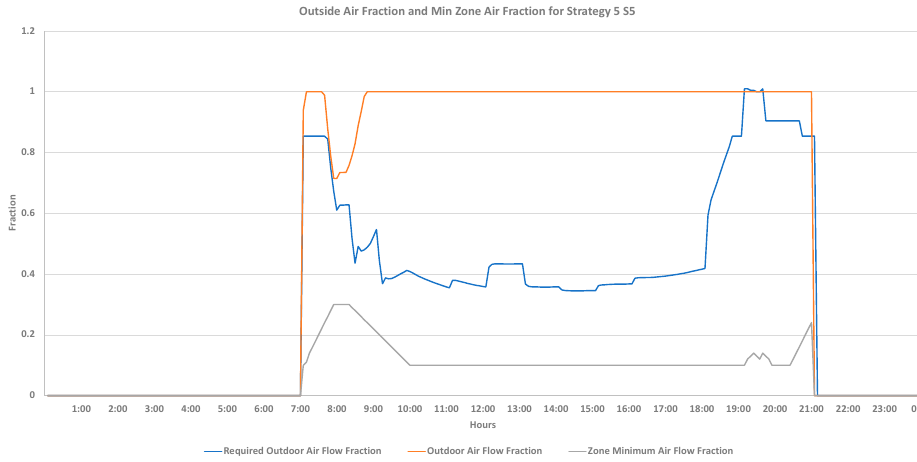
Figure 9. Required and introduced outdoor air fraction and minimum zone airflow set point when the strategy S5 was applied.